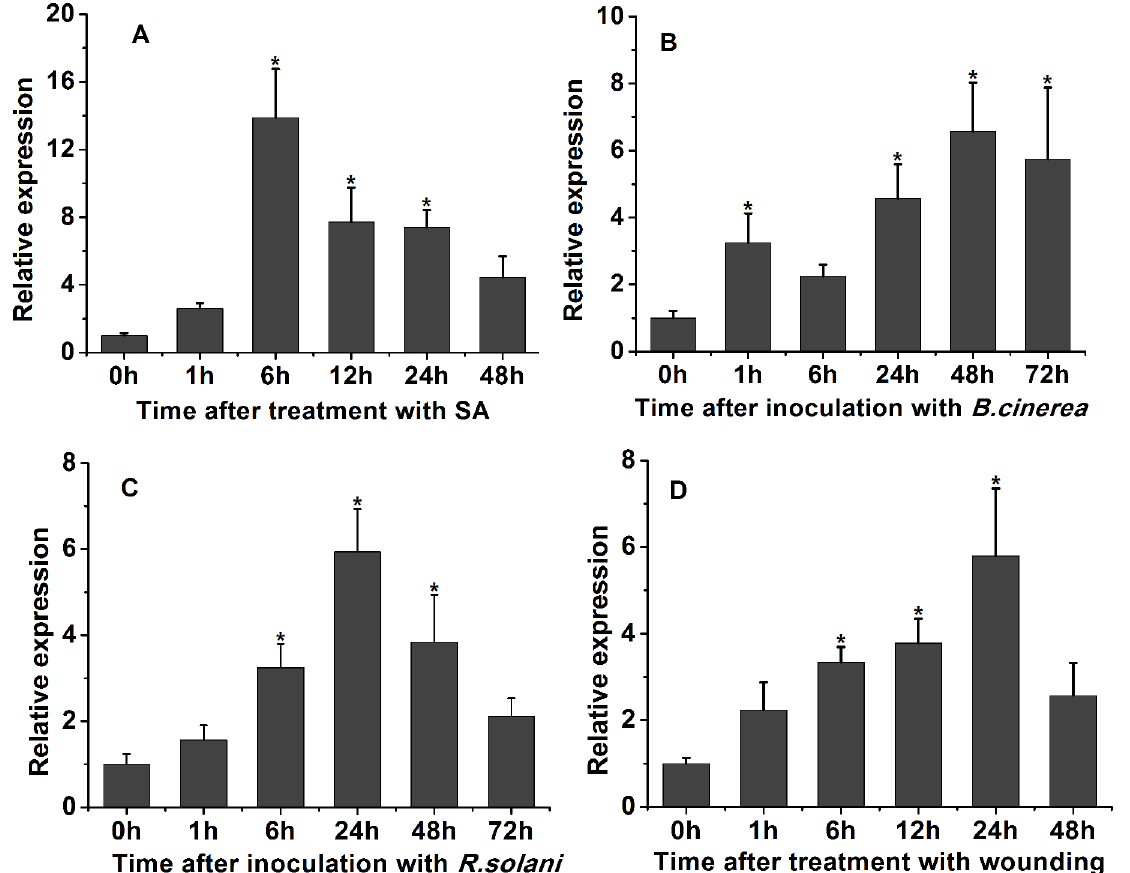
Fig 3. Analysis of CkPGIP1 expression by qPCR. A. CkPGIP1 expression 0, 1, 6, 12, 24 and 48 h after induction with salicylic acid. B-C. CkPGIP1 expression 0, 1, 6, 24, 48 and 72 h after inoculation with Botrytis cinerea ( B ) and Rhizoctonia solani ( C ). D. CkPGIP1 expression 0, 1, 6, 12, 24 and 48 h after wounding. Expression was compared to control plants, which were treated with double distilled water. Data were collected from three independent biological replicates. The data are means ± standard errors (n = 3). Asterisks indicate a significant difference compared with control [least significance differences (LSD), * P <